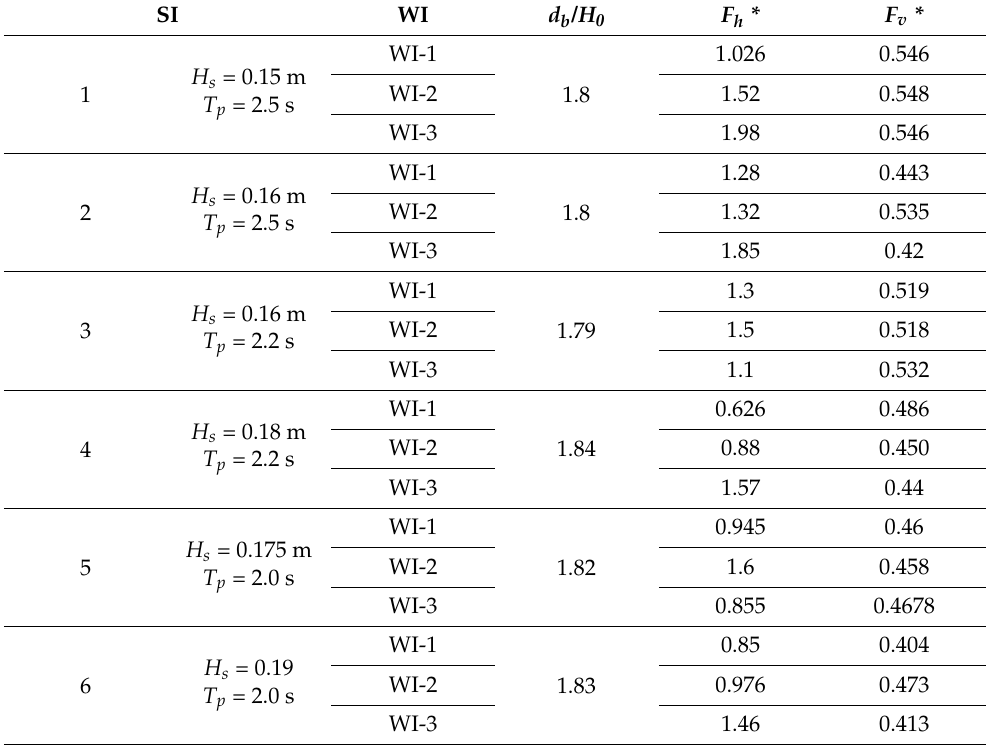
Table 3. Different wave impact scenarios and the impact forces obtained. SI WI d b /H 0 F h * F v * H s = 0.15 m 1 T p = 2.5 s